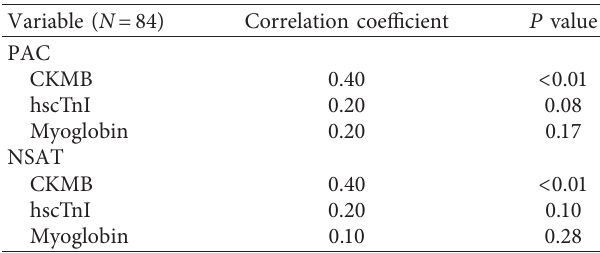
Data are expressed as mean (SD) or median (IQR) for continuous variables and number (%) for categorical variables. AF, atrial fibrillation; AVB, atrioventricular block; CKMB, creatine kinase isoenzyme; COVID-19, novel coronavirus disease 2019; hscTnI, high-sensitive cardiac troponin I; PAC, premature atrial contracts; PVC, premature ventricular contracts; NSAT, nonsustained atrial tachycardia; NSVT, nonsustained ventricular tachycardia. Table 4: The correlation between arrhythmias and cardiomyocyte injury markers